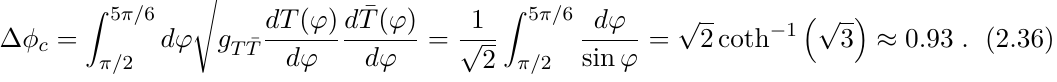
(3) + is obtained as X 0 (3) 0